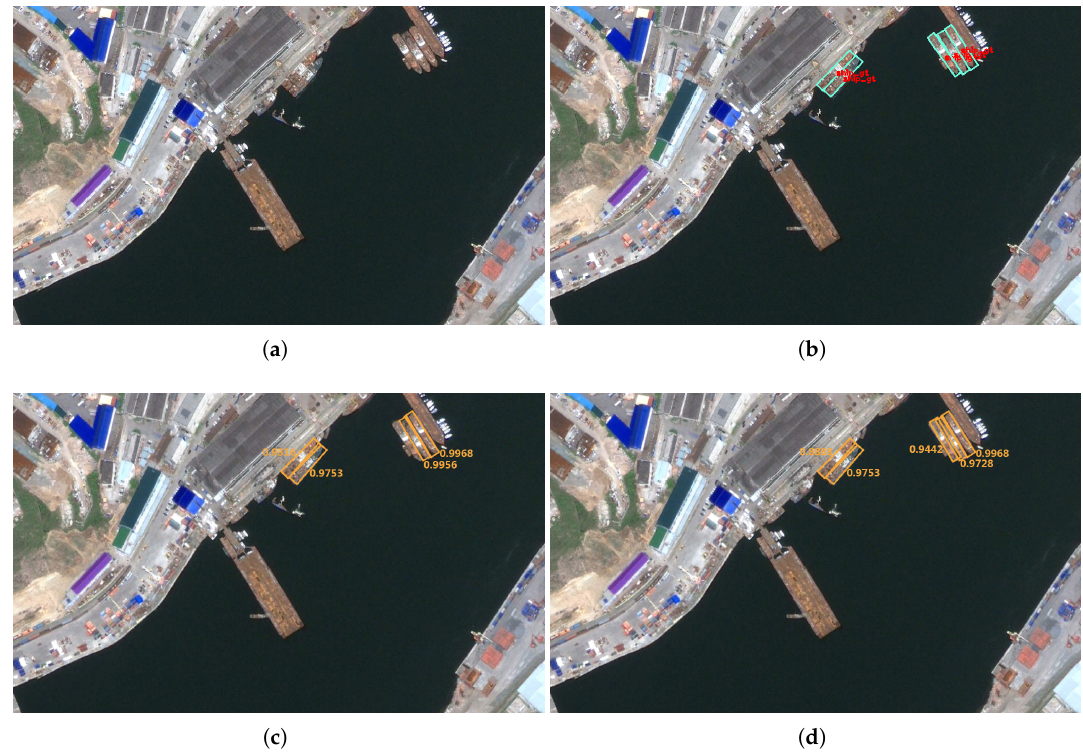
Figure 16. Different results of Rotation Non-Maximum Suppression (RNMS) and Soft Rotation Non-Maximum Suppression (SRNMS). ( a ) the original remote sensing image; ( b ) the inclined rectangle ground truths of ships; ( c ) processing result of RNMS; ( d ) processing result of